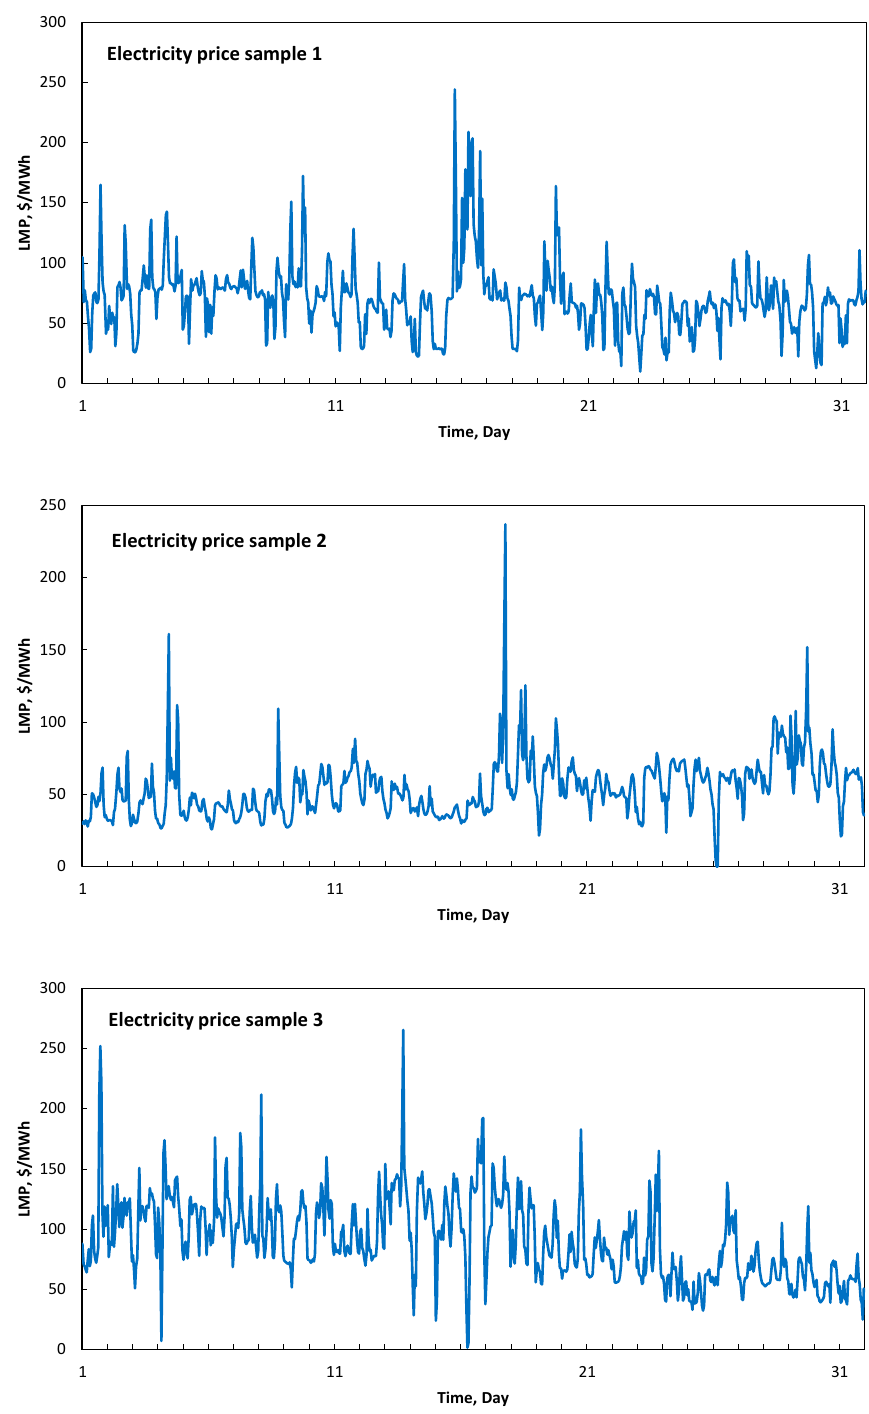
Figure 4. Time series plots of three electricity price data samples. Table 7. Estimated parameters and performance measures for the first electricity price sample.